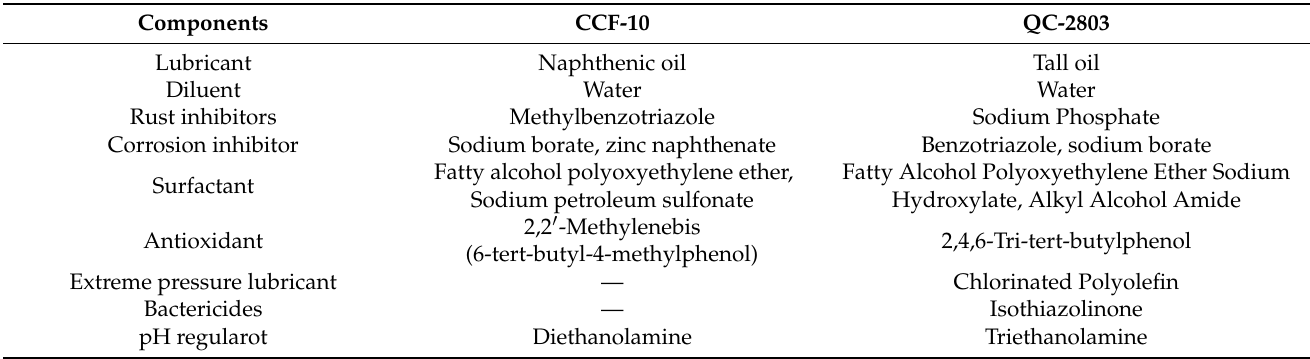
Table 2. The main components and functions of two cutting